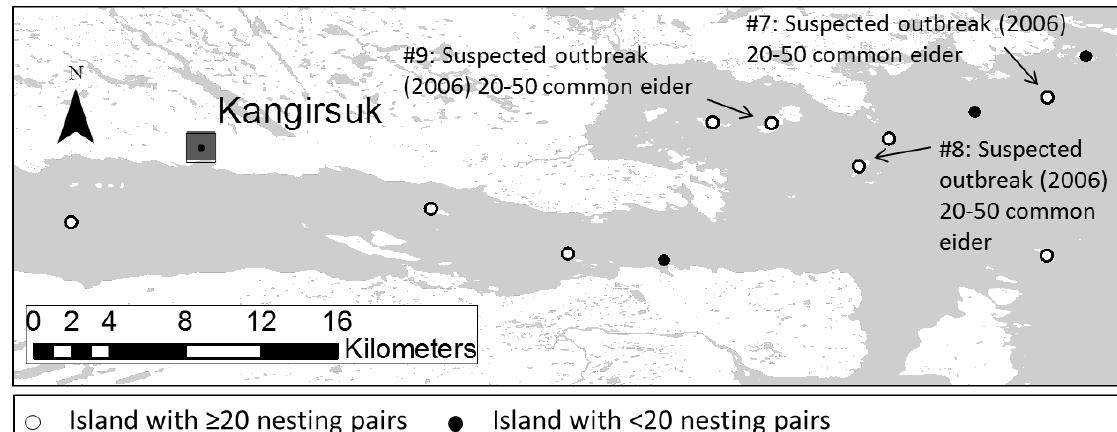
Figure A1.2. Survey zone 2: Payne Bay, Western Ungava